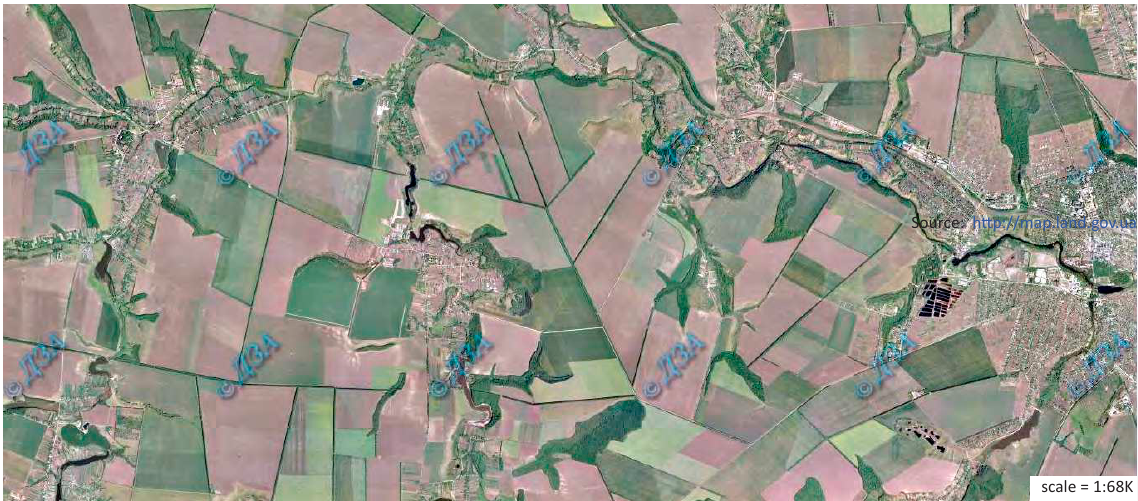
Figure 4. Orthophoto image of key plot 2